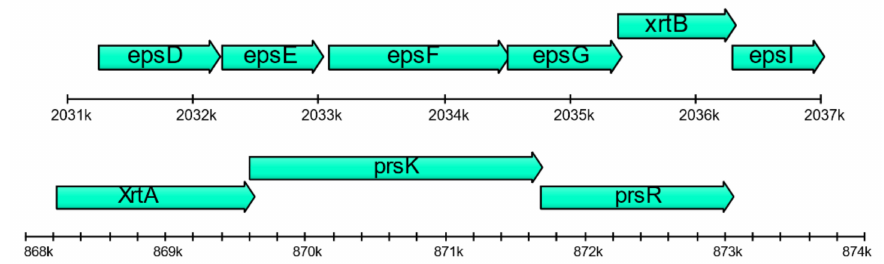
Figure 4. Schematic diagram of the genetic organization of Janthinobacterium sp. SLB01 gene clusters required for floc formation: exopolysaccharides (EPS) synthesis, PEP-CTERM, and exosortase. Genes are indicated by arrows and the direction of the arrows represents the direction of transcription of the genes in the